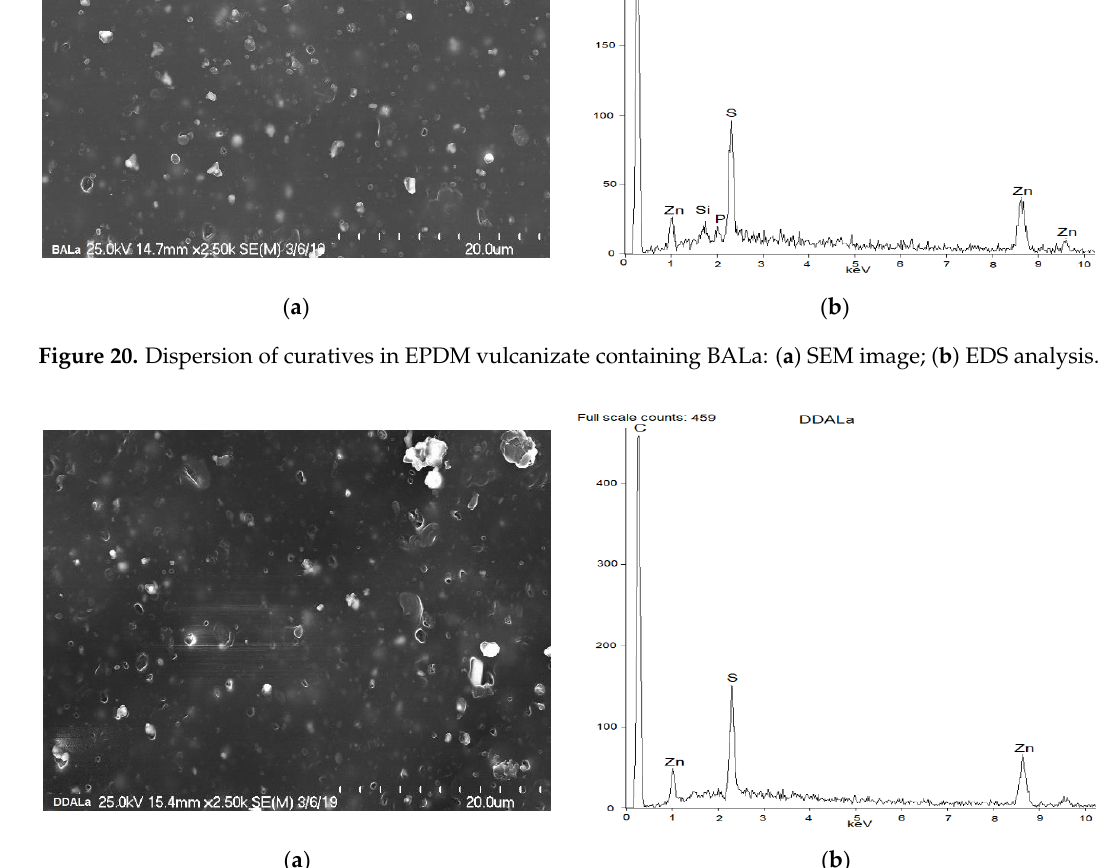
( b ) Figure 22. EDS maps for EPDM vulcanizate containing: ( a ) BALa; ( b ) DDALa. SEM image showed that dispersion of the curative particles in the reference vulcani- zate without addition of IL was inhomogeneous (Figure 19). The average size of created agglomerates was greater than 1 μm and these agglomerates were poorly wetted by the elastomer matrix. Bands for Zn and S elements in the EDS spectrum collected for this vul- canizate indicated that the agglomerates showed in the SEM image mainly consisted of ZnO and sulfur. This could also be ZnS, which is formed as a by-product during cross- linking reactions. From analysis of SEM images of the vulcanizates with TSILs (Figures 20 and 21), the dispersion of curatives was quite homogeneous, especially for BALa (Figure 20), although it was more of a microdispersion than a nanodispersion. The clusters of par- ticles were uniformly distributed in the EPDM matrix and well wetted by the elastomer. The bands for C, Zn and S elements were identified in the EDS spectra of the vulcanizates containing TSILs. To determine which components of the curing system have the greatest tendency to agglomerate in the elastomer matrix, EDS analysis was also presented in the form of maps. Examples of EDS maps for the vulcanizates containing BALa and DDALa are shown in Figure 22.